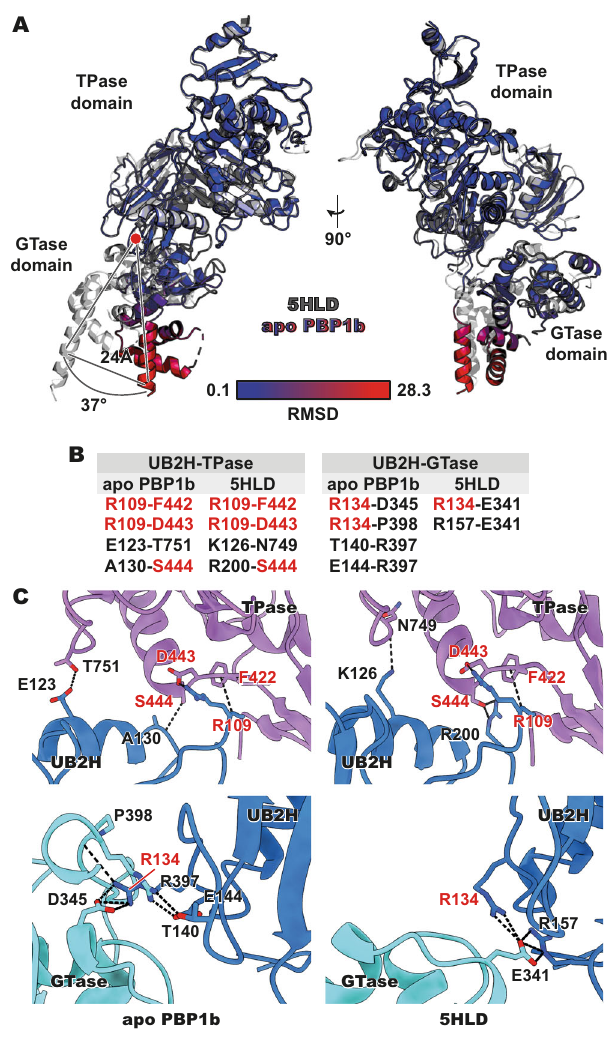
Fig. 2 Domain rearrangement and differential inter-domain interfaces. A Meropenem- and acyl-CENTA-bound E. coli PBP1b (PDB 5HLD) and apo E. coli PBP1b superimposed. Liganded PBP1b (PDB 5HLD) is in grey, while residues of apo PBP1b are coloured by RMSD from blue (0.1Å) to red (28.3 Å), with an average RMSD of 3.2Å across all modelled residues. There is a striking rotational reorientation of the GTase (glycosyltransferase) domain between the two structures. The GTase domain is seen to rotate 37° and the TM side of the domain is rotated at a distance of 24Å. B The various hydrogen bonds at the domain interfaces (UB2H (putative activator binding)- TPase (transpeptidase) and UB2H-GTase) are listed. Residues and/or residue pairs that play a role in both structures are in red font. C The interdomain interfaces (UB2H-TPase and UB2H-GTase) of both apo PBP1b and liganded PBP1b (PDB 5HLD). Residues involved in hydrogen bonding are labelled as in ( B ). Hydrogen bonds are represented by dashed lines. Domains are coloured as in ( B ), with TPase in purple, UB2H in blue, and GTase in